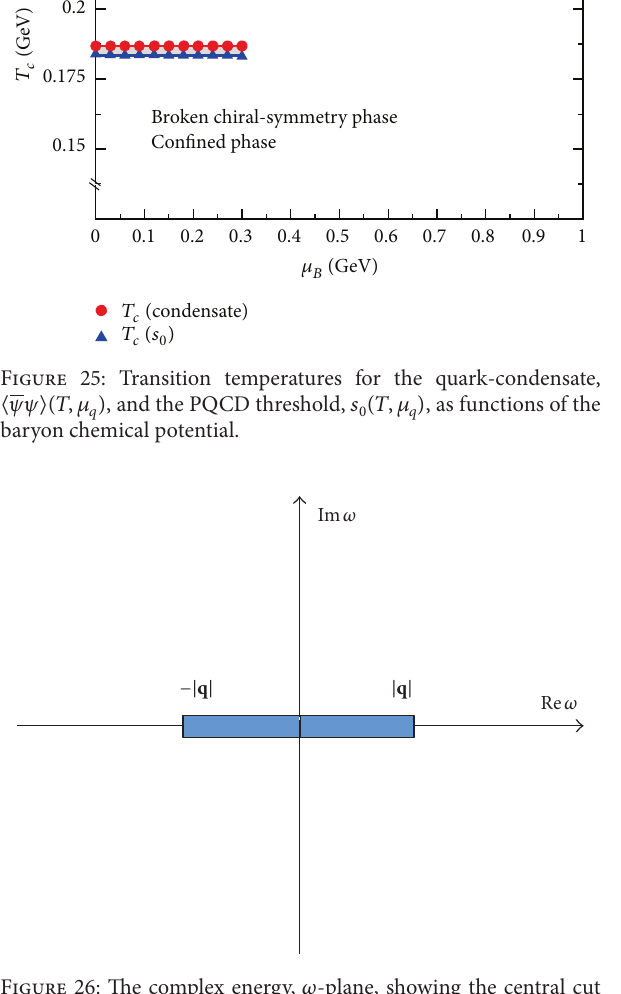
Figure 26: The complex energy, 𝜔 -plane, showing the central cut around the origin (scattering term), extending between 𝜔 = −| q | and 𝜔 = | q | . The standard (time-like) annihilation right-hand and left-hand cuts at 𝜔 = ±[| q | 2 + 𝜔 2 th ] 1/2 are not shown ( 𝜔 th is some channel dependent mass